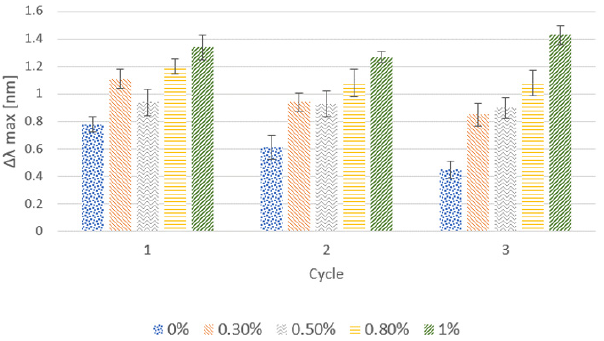
Figure 3. Δλ maximum for samples formulated with SLES/CAPB 12 wt. % and different levels of the cationic polymer at room temperature and pH ~7.